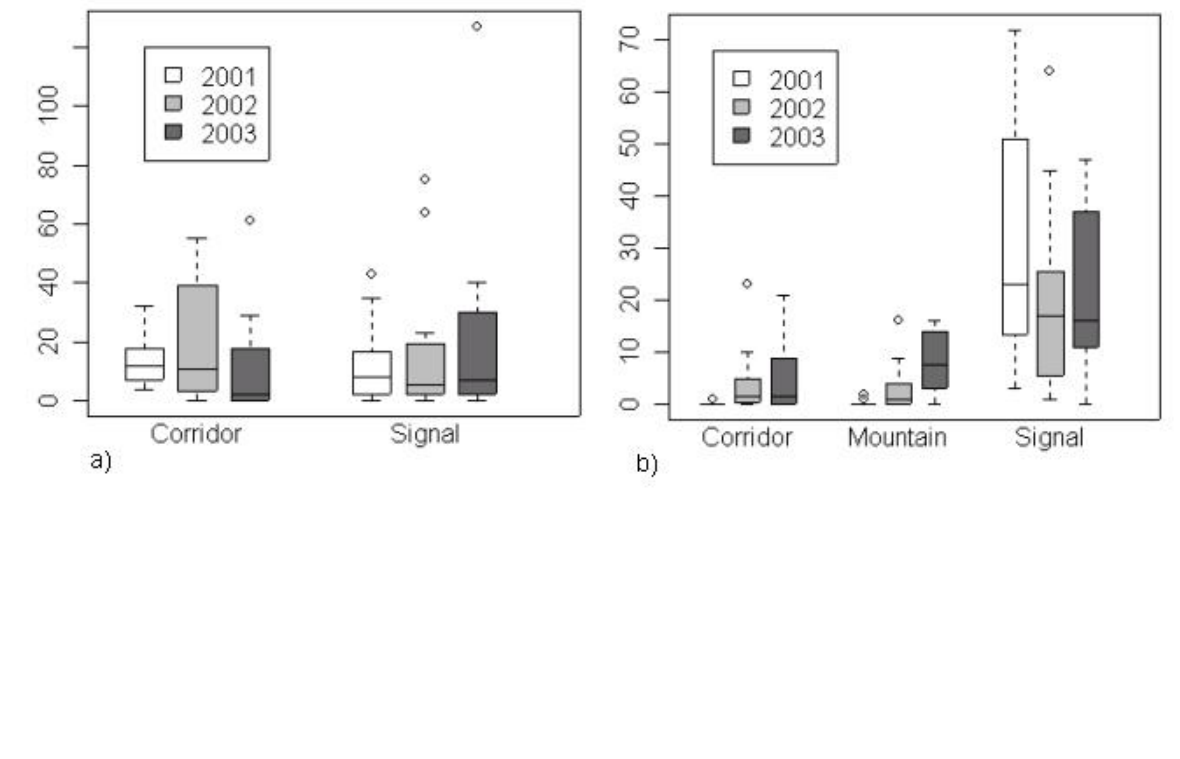
Fig. 4. Boxplots of the number of (a) elk and (b) deer in the corridor, mountain, and signal nodes prior to and following corridor restoration. Deer rarely used the proshop node; therefore, this node was omitted from the